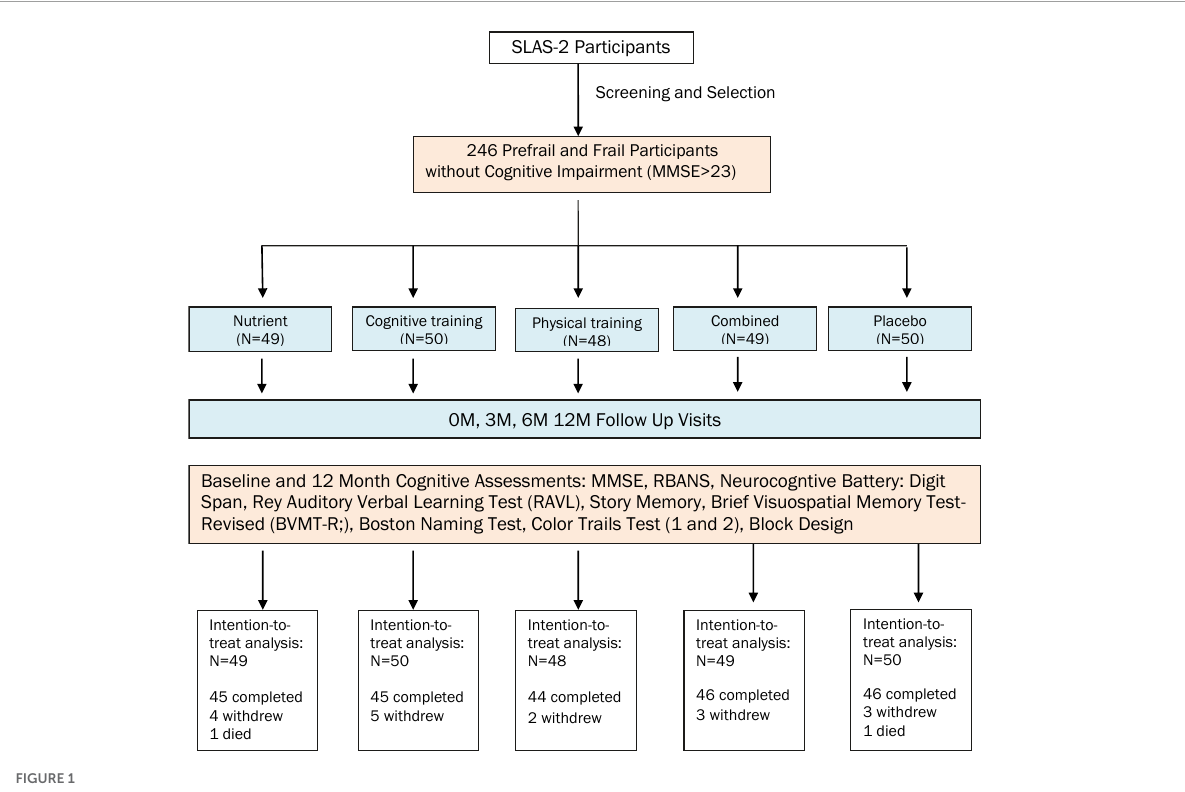
FIGURE1 Participant recruitment flowchart in the exploratory study.